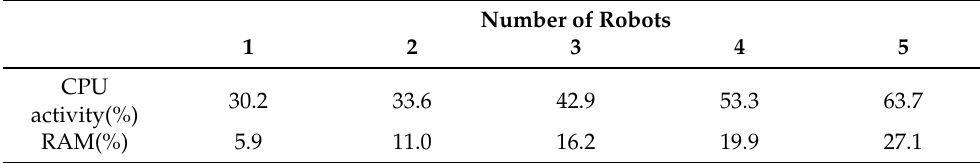
Table 3. CPU activity and peak RAM in the Fog Node for up to five parallel working robots. Number of Robots